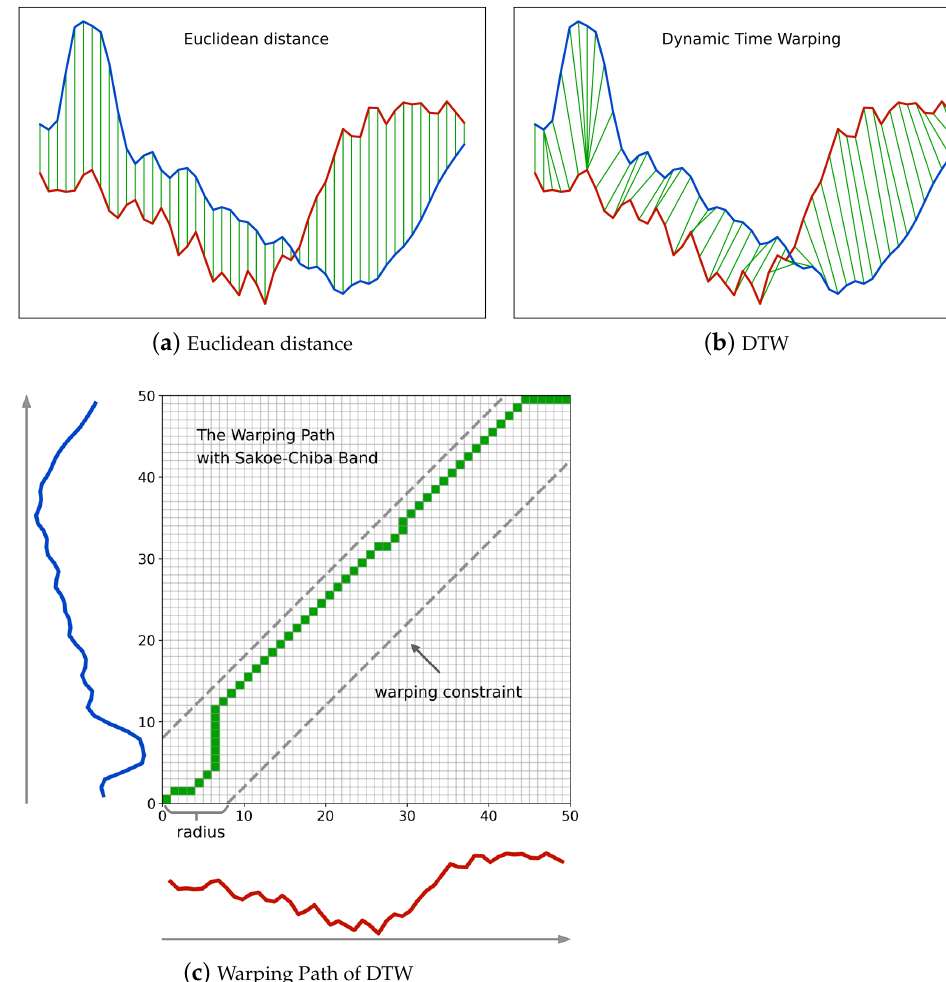
Figure 2. Examples of Euclidean distance, DTW and the warping path of DTW with Sakoe– Chiba